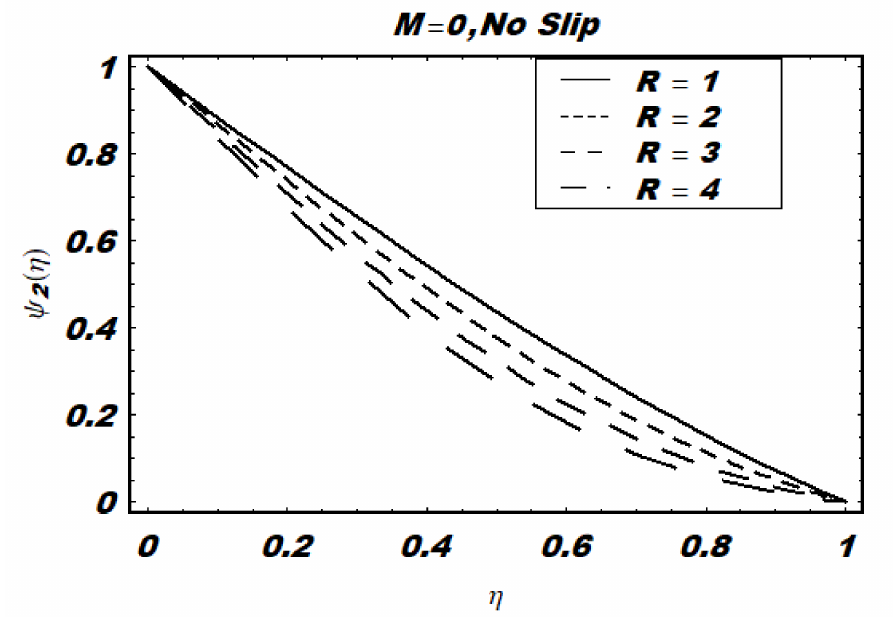
Figure 8. Similarity function ψ 2 for the long slider.